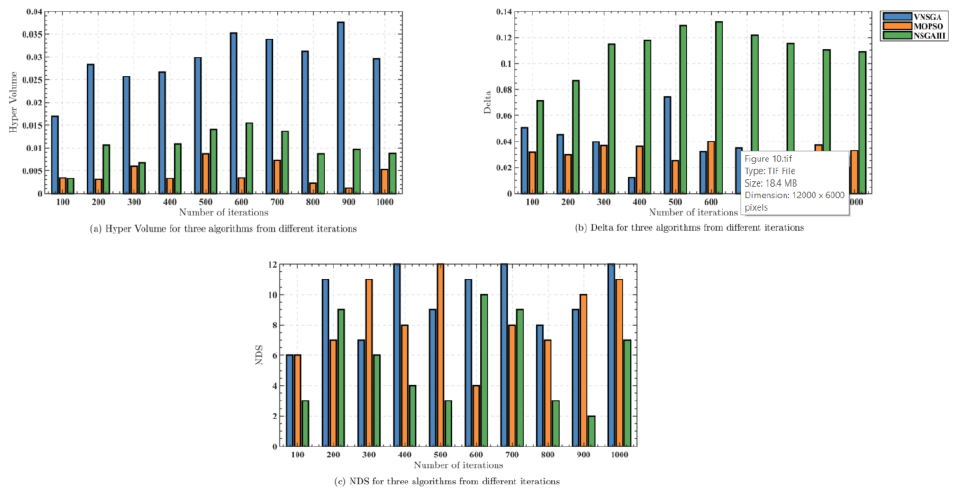
Figure 10. Hyper volume, Delta, and NDS for three algorithms from different iterations for 50 m R s max and 100 m R c max with respect to area A.